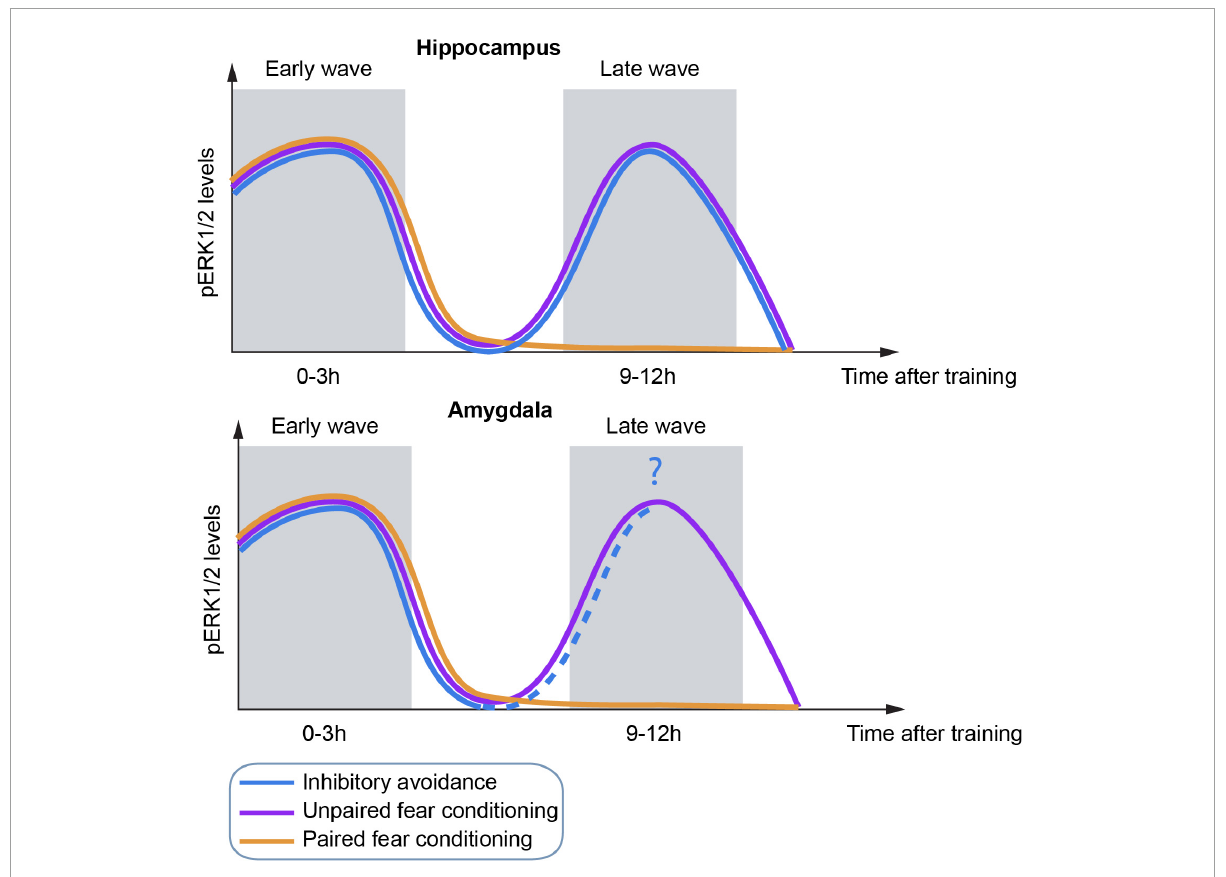
FIGURE2 Schematic representation of temporal dynamics of ERK activation in the hippocampus (top) and amygdala (bottom) by three different fear behavioral